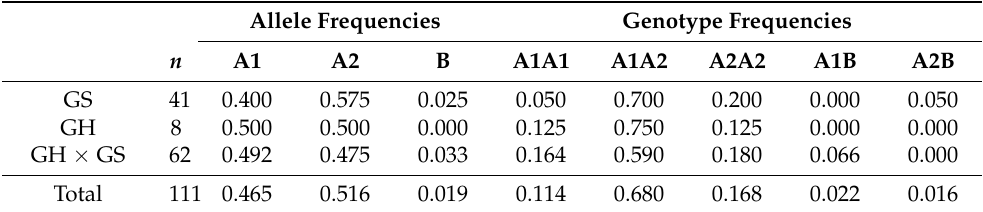
Table 2. Allele and genotype frequencies for β -casein by breed groups. Allele Frequencies Genotype Frequencies